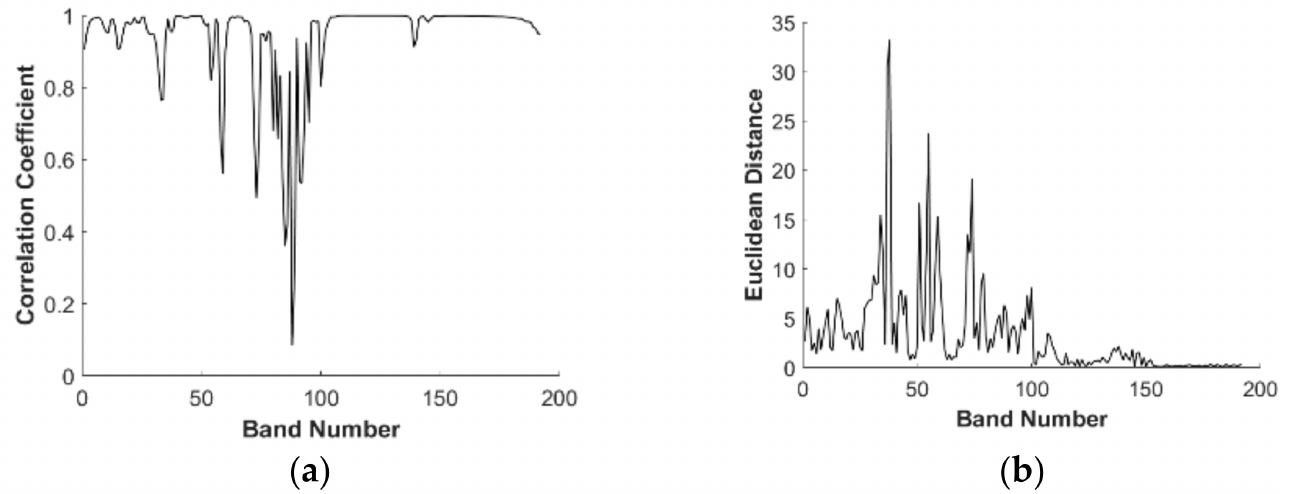
Figure 2. Visualization of the correlation between adjacent bands on the Indian Pines data set ( a ) Correlation coefficient ( b ) Euclidean